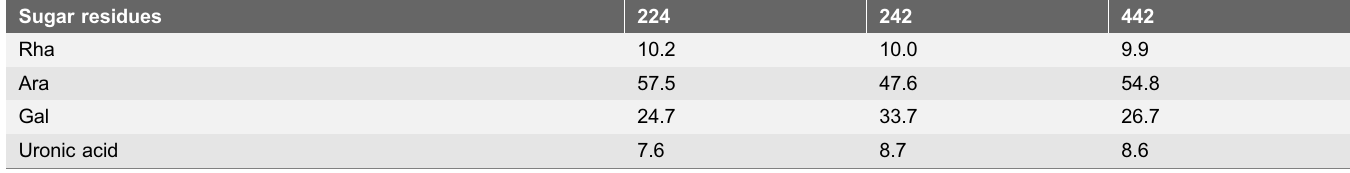
Table 2. Sugar composition of three glycomodules isolated from the culture media of individual transgenic cell line. Sugar residues 224 242 Rha Ara Gal Uronic acid The data were shown as molar percentage. The presented numbers were average of two